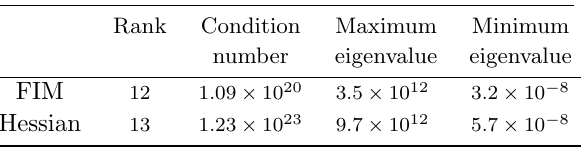
Table 11: The FIM and Hessian analysis for the iden- tifiability